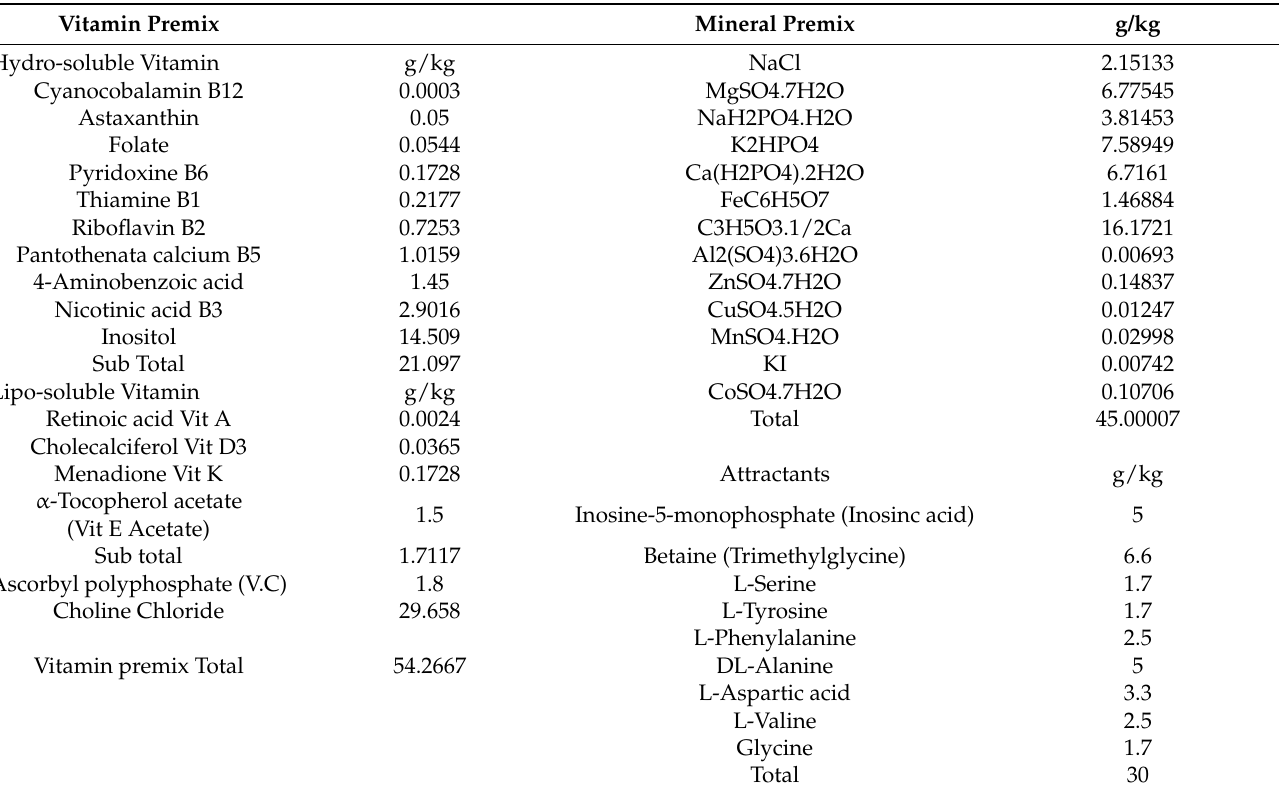
Table 2. Vitamins, minerals, and attractants formulation in the experimental